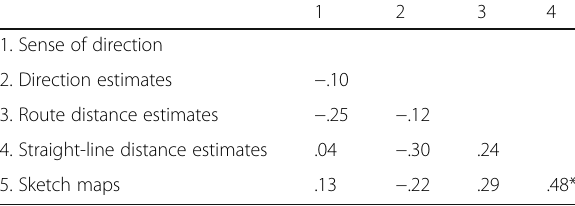
Table 2 Correlations among spatial tasks and sense of direction